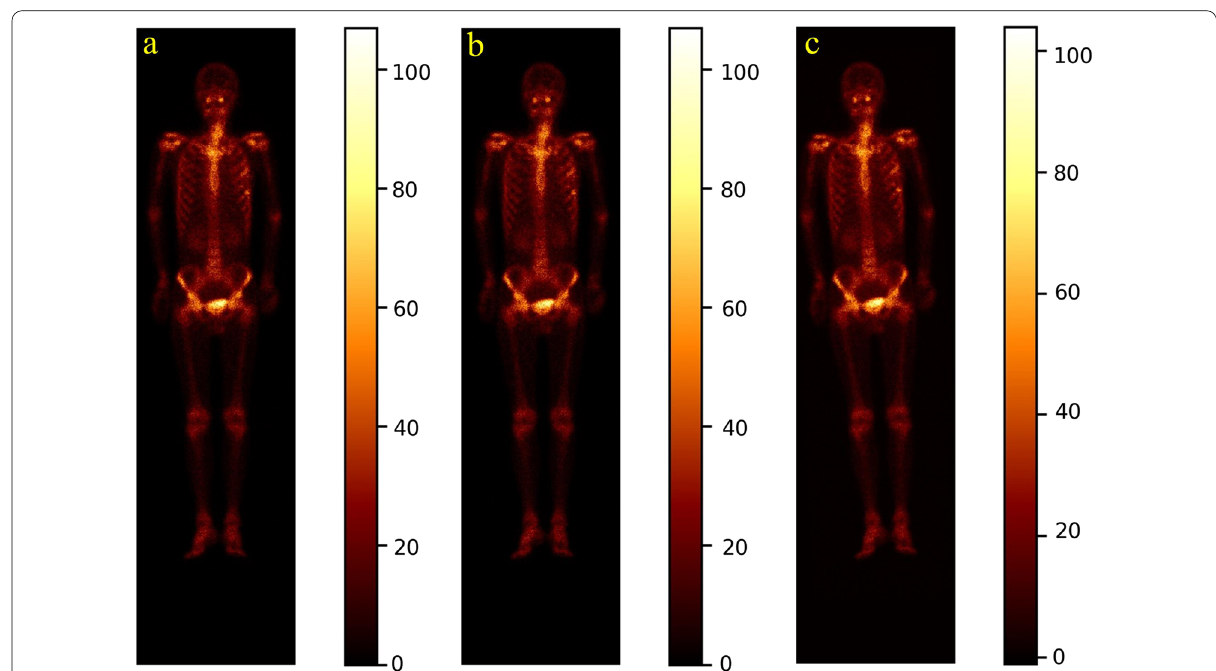
Fig. 3 Illustration of translating and rotating whole-body SPECT scintigraphic image. a Original posterior image; b Translated image; and ( c ) rotated image by 3° to the left